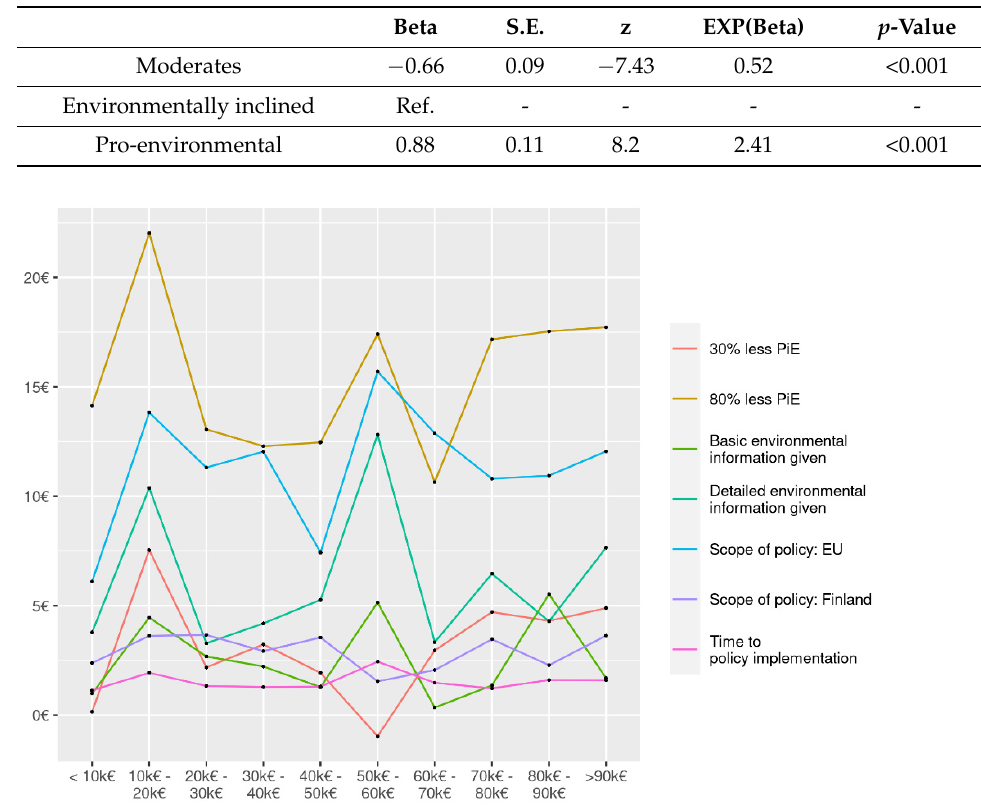
Figure A1. Household gross income and WTP for attribute levels of a greener pharmaceutical policy.